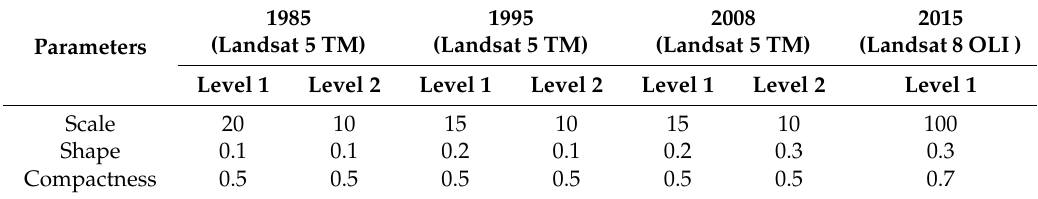
Figure 3. Flowchart of the image classification process. Table 2. Segmentation parameters applied in the di ff erent